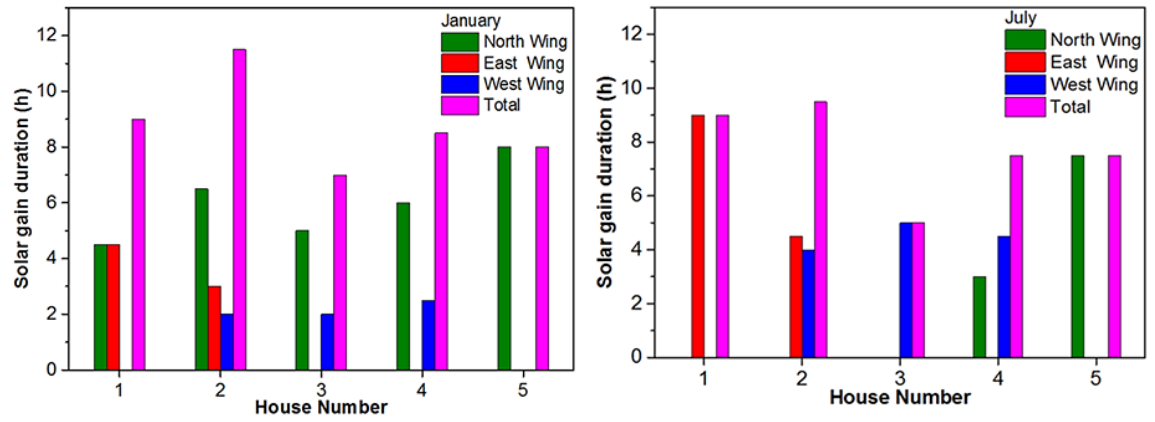
Diagram 1 Comparison of duration of direct solar gain Diagram 2 Comparison of duration of direct solar gain for 5 studied houses in month January for 5 studied houses in month